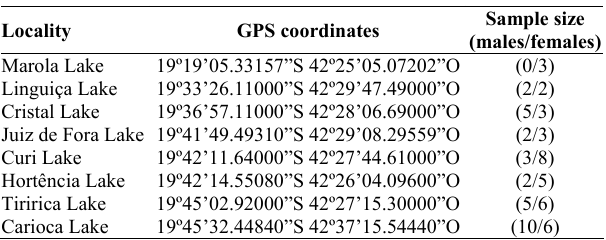
Table 1. Geographical location and sample sizes in lakes of the middle rio Doce Valley, MG,